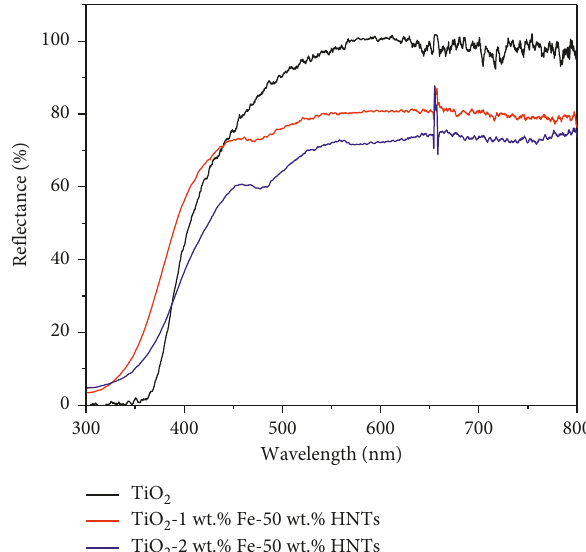
Figure 8: DRS analysis of TiO 2 and TiO 2 -Fe-HNT